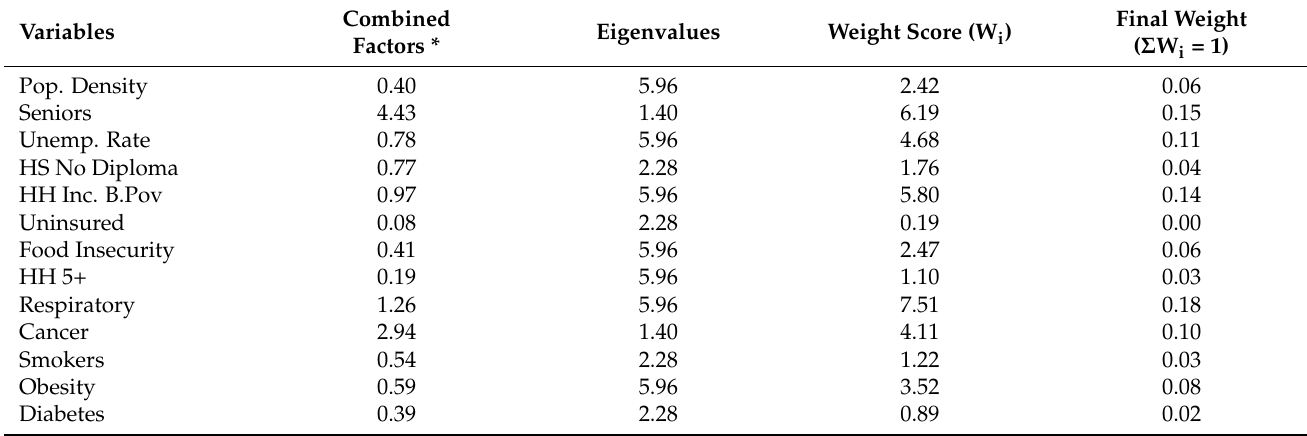
Table 4. Eigenvalues and weight scores for the Exposure subindex.